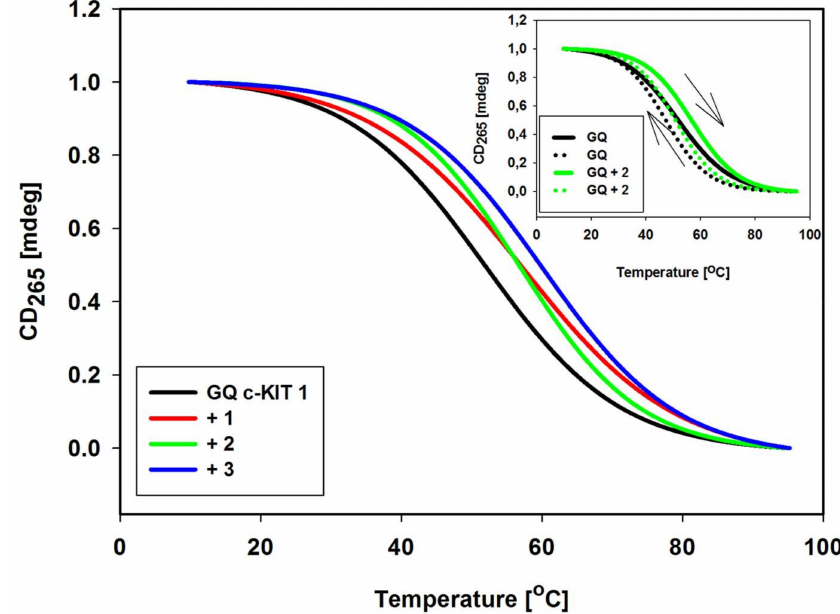
Figure 6. Normalized CD melting profiles of c-KIT 1 G-quadruplex at 265 nm with and without 3 eq of ligands 1 – 3 in 10 mM Tris-HCl buffer (pH 7.2) containing 90 mM LiCl and 10 mM KCl. Inset: The effect of rates of heating and cooling on CD profiles of GQ c-KIT 1 in absence and presence of ligand 2. Solid lines are melting curves, dotted lines are annealing